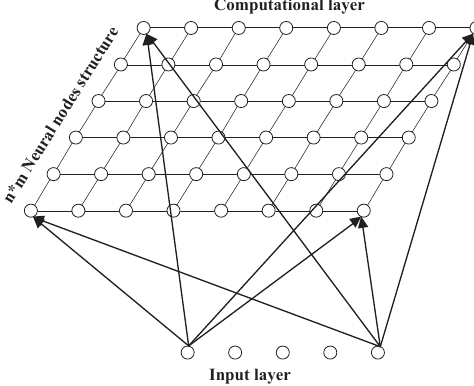
Figure 2. Typical SOM neural network